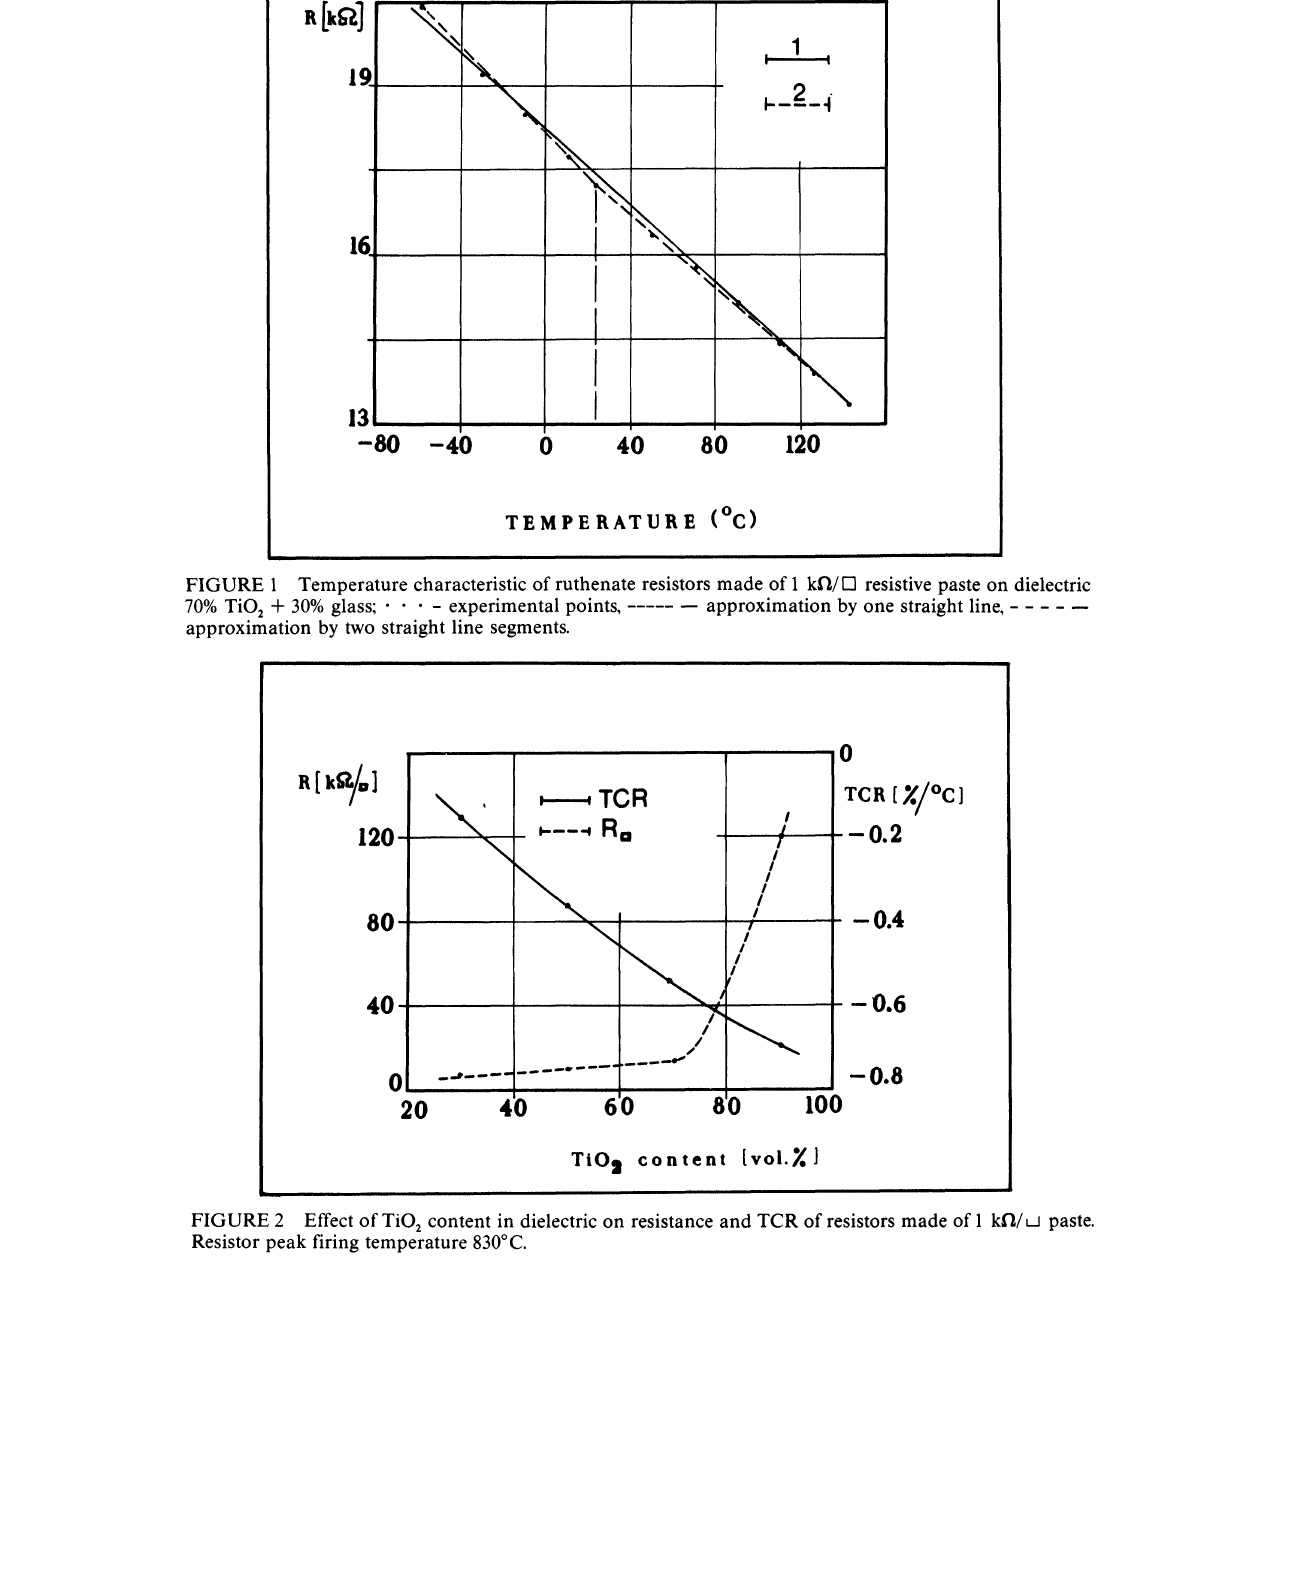
FIGURE 2 Effect of TiO content in dielectric on resistance and TCR of resistors made of kf/L_l paste. Resistor peak firing temperature